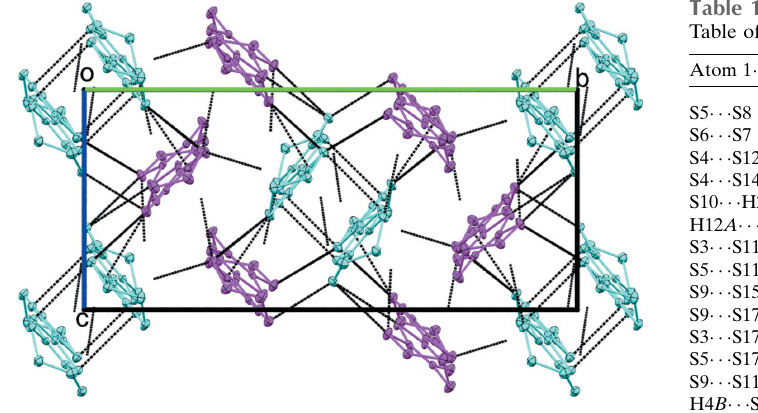
Figure 4 View along [100] of the packing of the molecular entities in the crystal structure of (BEDT-TTF) 4 [Cu(NCS) 4 ]. The dimer of BEDT-TTF mol- ecules (turquoise) is surrounded by other BEDT-TTF molecules (purple). Black dotted lines represent short S (cid:2)(cid:2)(cid:2) S and S (cid:2)(cid:2)(cid:2) H contacts shorter than the sum of the van der Waals radii (for numerical details, see: Table 1).